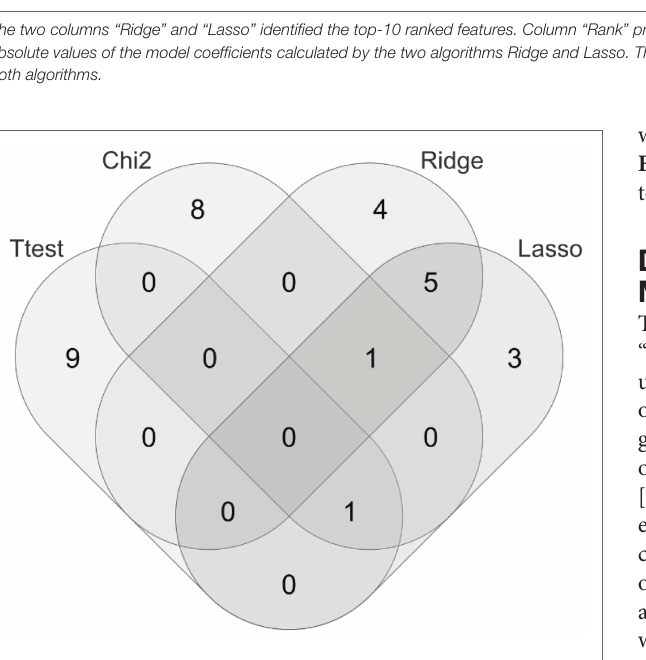
FIGURE 2 | Venn diagram of the top-10 features ranked by the four feature selection algorithms. The feature selection algorithms were T-test (Ttest), Chi-squared test (Chi2), Least Absolute Shrinkage and Selection Operator (Lasso), and ridge regression